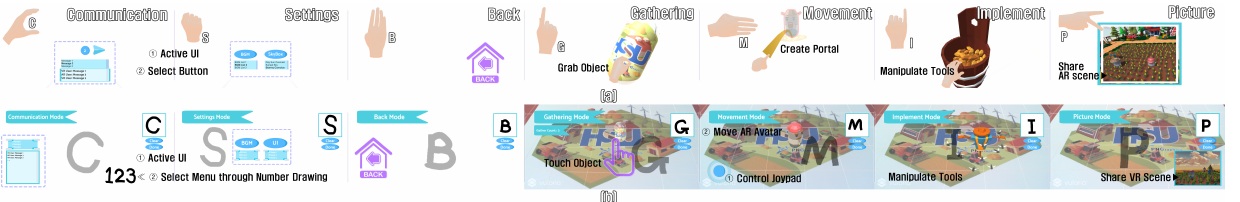
Figure 5. Process by which VR and AR users perform the mode transition action based on the proposed interface via deep learning: ( a ) VR user and ( b ) AR user.